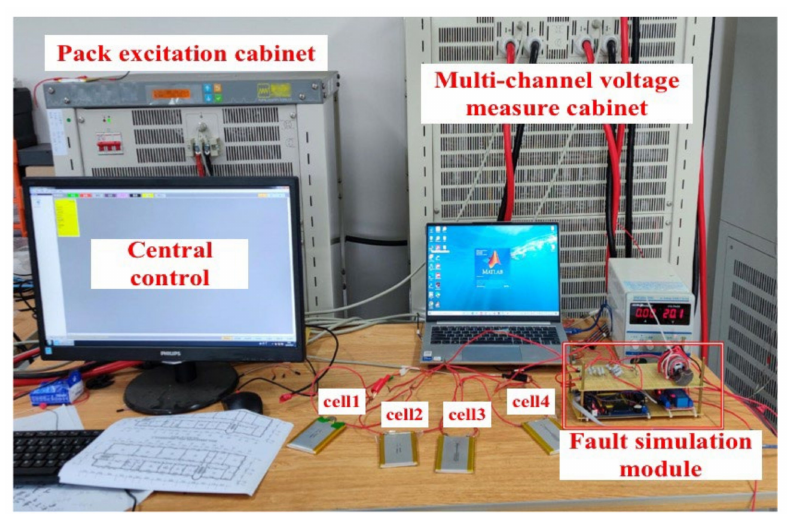
Figure 3. Physical view of experimental